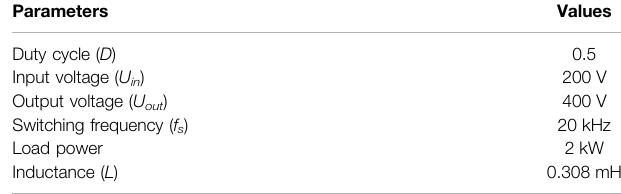
TABLE 1 | Parameters of the experimental